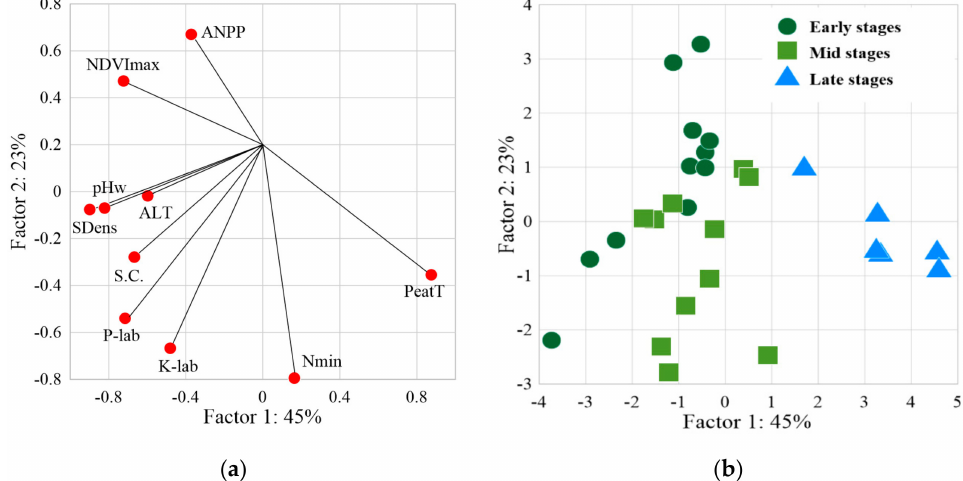
Figure 11. Results of the PCA treatment of the soil trophic parameters and vegetation productivity: ( a )—the relationship between the input parameters and 2 possible factors (ANPP—aboveground net primary production; NDVImax—average maximum NDVI value for 2016–2019; ALT active layer thickness; pHw—pH of soil water; S.C.—specific electrical conductivity; SDens—soil density; P-lab—labile phosphorus; K-lab potassium; Nmin—mineral compounds of nitrogen; PeatT—peat thickness), ( b )—studied sites of three successional stages of the khasyreys in relation to possible factors (stages: Ea—early; Mi—mid;